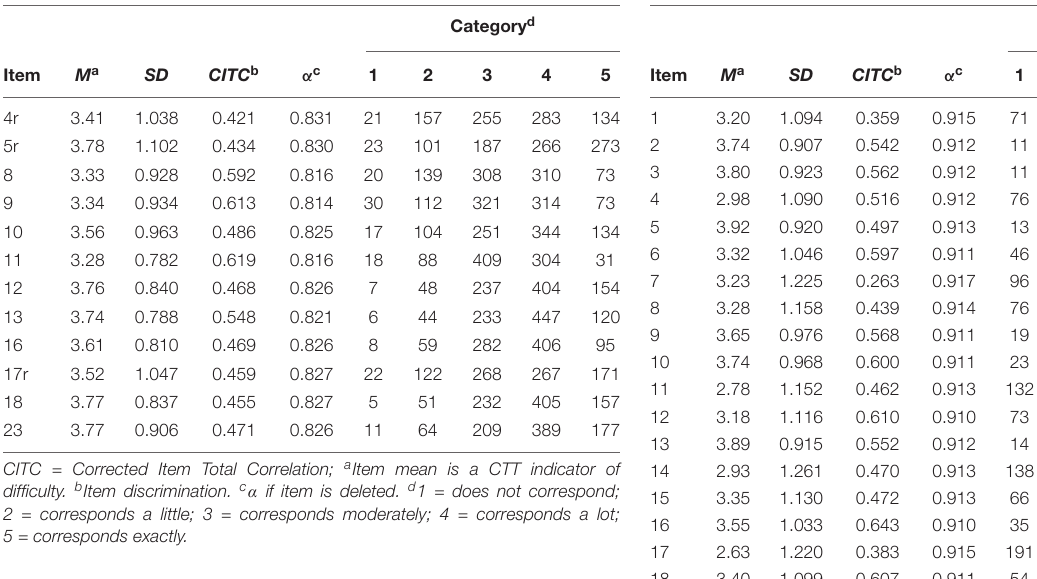
TABLE 5 | Classical item analysis of the forethought scale ( α = 0.92, CI 95 = 0.91,